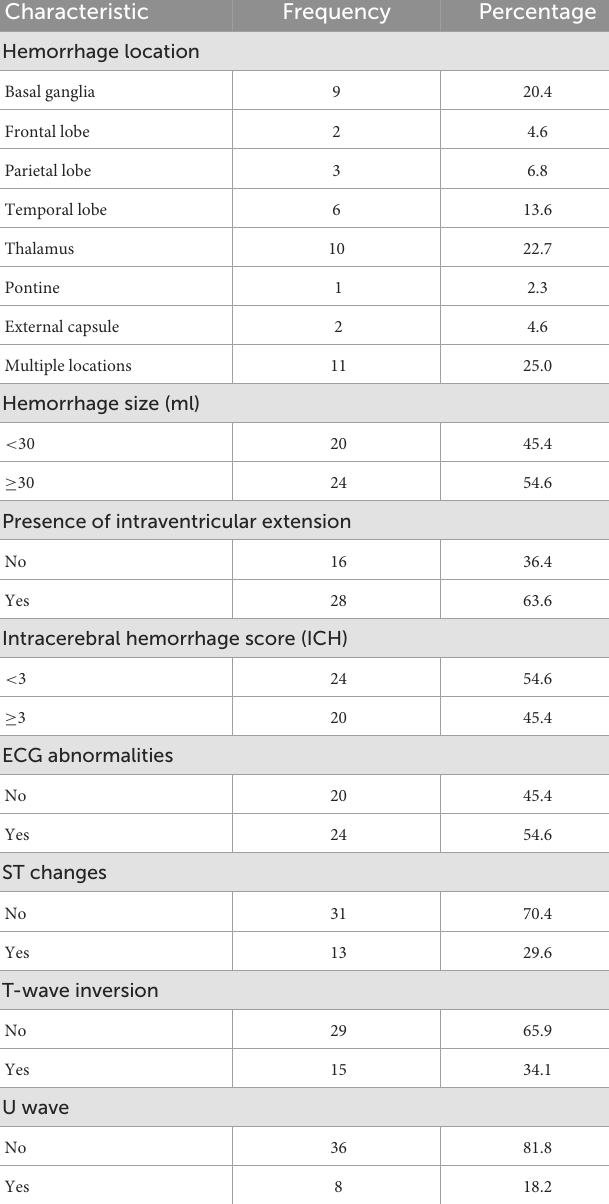
TABLE 4 Neuroimaging and ECG abnormalities among patients with ischemic stroke ( N = 81).